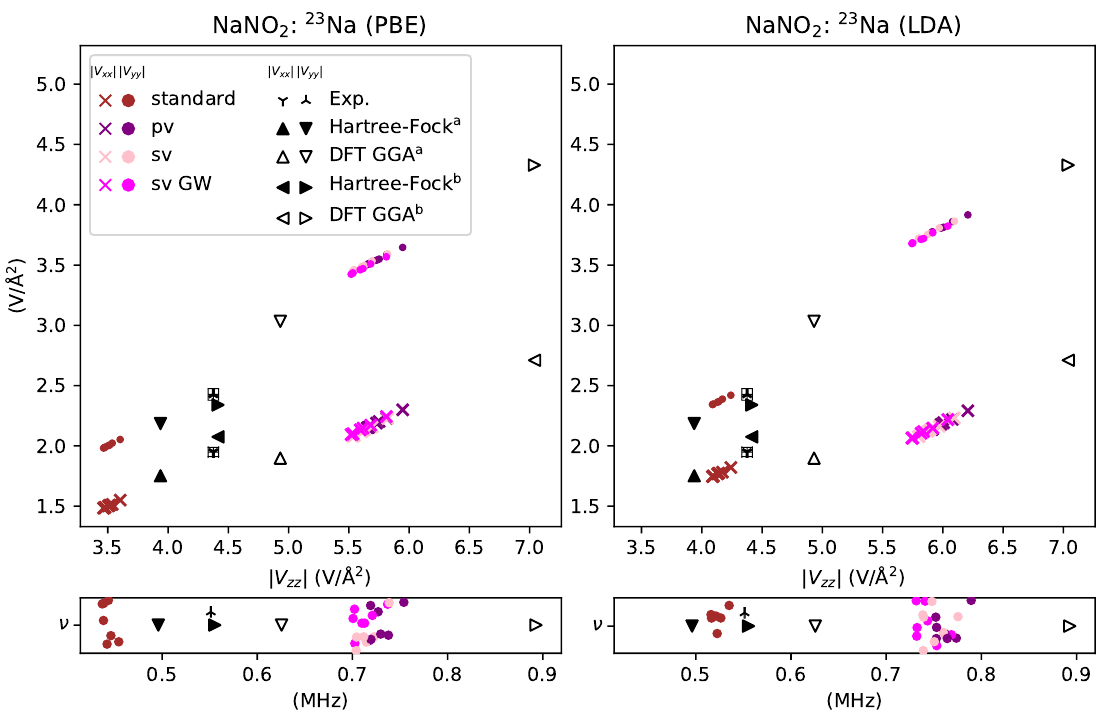
Figure 4. EFG plots for the 23 Na site in NaNO 2 , utilizing both PBE (left) and LDA (right) functionals, are shown at the top; the corresponding NQR frequencies are shown underneath. Colored markers show a computed value for each PAW potential. Experimental data [43] is shown as a three-pointed star and fell between the computed values. Available literature data [30], shown in black, were calculated with Hartree–Fock and DFT using linear combinations of atomic orbitals (LCAO) as a basis set, with superscript a = [8-511/8-41/8-411] and b = 6-21G. The V xx and V yy components were computed to be positive and V zz